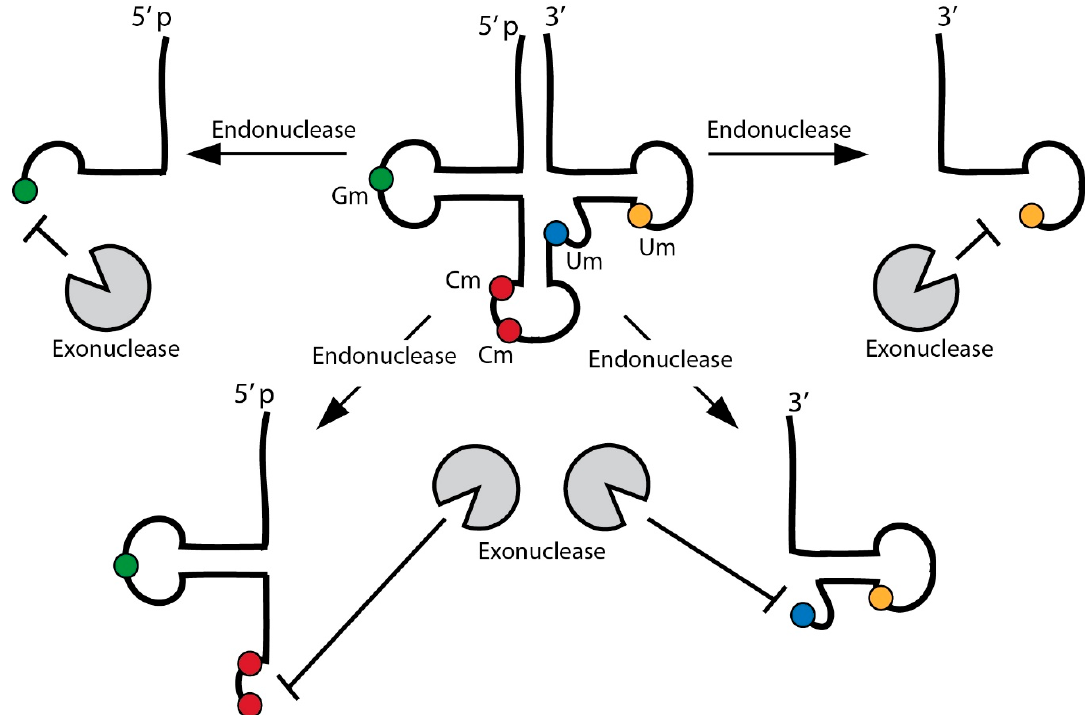
Figure 2. Specific tRNA modifications might influence tsRNA stability. Various tRNAs contain particular RNA modifications that inhibit the access of 3 ′ -5 ′ exonucleases. In particular, the positioning of 2 ′ - O -methylated nucleotides (Cm, Gm, Um) in open loop structures suggests that such modifications might stabilize produced tsRNAs against degradation.